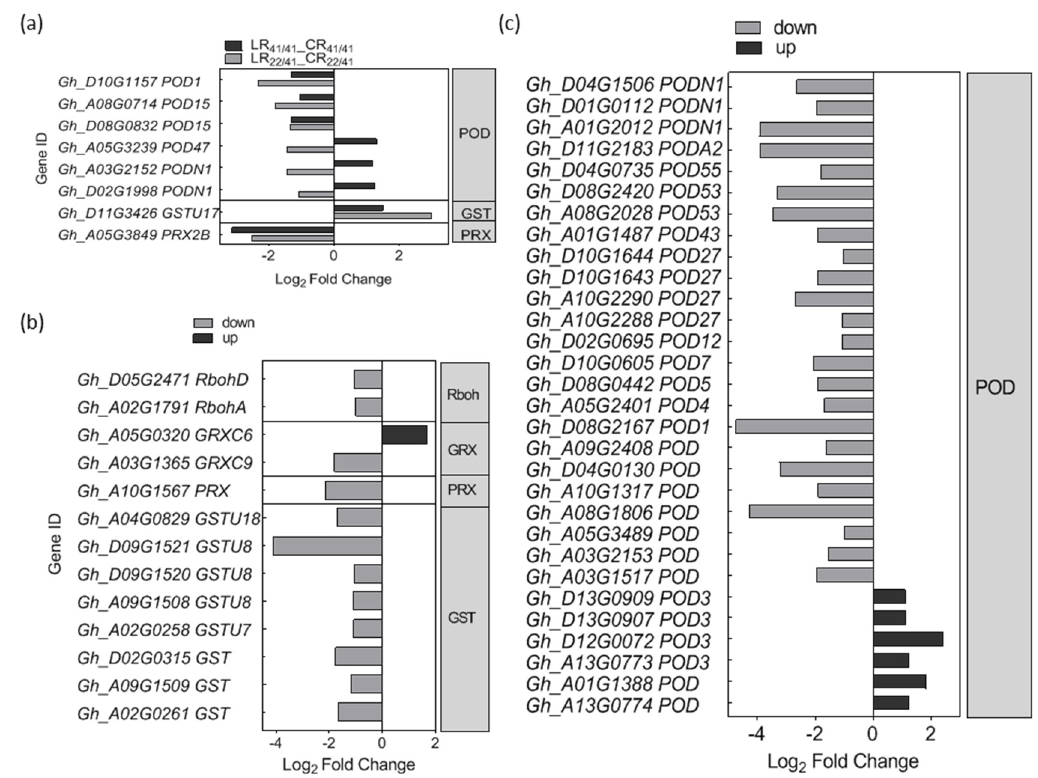
Figure 4. The differently expressed genes (DEGs) involved in ROS (reactive oxygen species) signaling in R common ( a ) and R 22/41 unique ( b , c ) group. R common: Common DEGs in roots of CCRI41/CCRI41 (scion/rootstock) and SCRC22/CCRI41 under potassium (K + ) deficiency. R22/41 unique: DEGs specifically identified in roots of SCRC22/CCRI41.